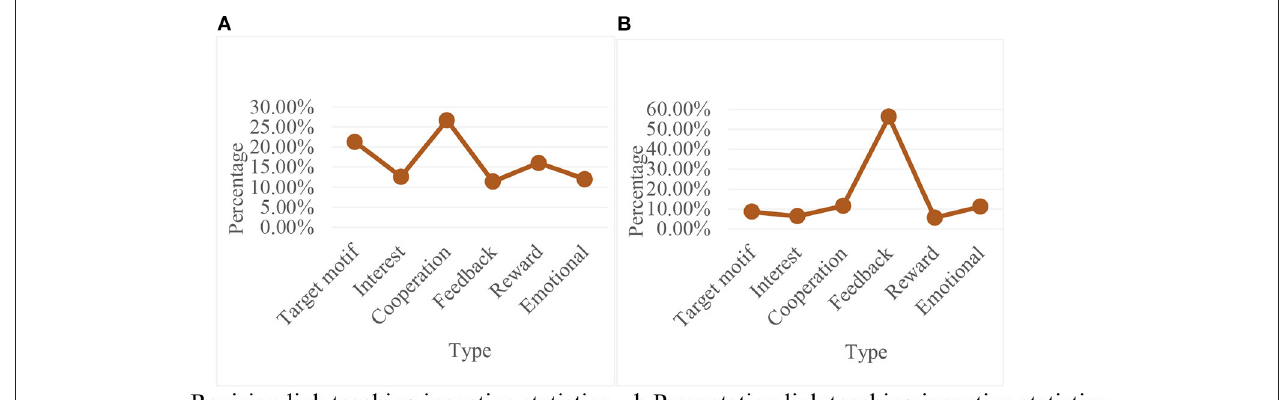
FIGURE 10 | Statistical chart of the influence of teaching incentives in various links in the classroom. (A) Revision link teaching incentive statistics. (B) Presentation link teaching incentive